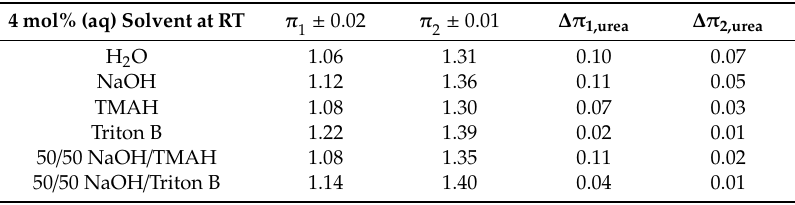
Table 2. The π parameters for the specified solvent and the di ff erence in π for the same solvent with urea, obtained at room